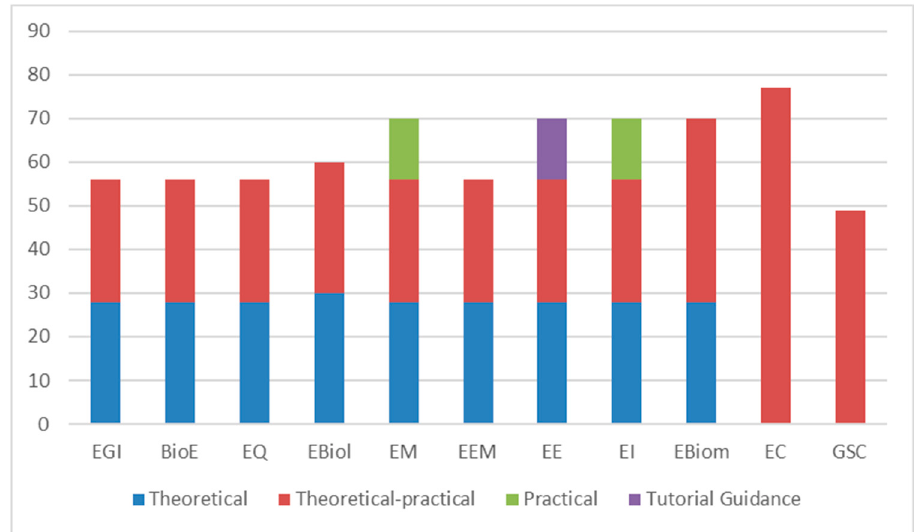
Figure 2. On-site classes distribution of the different CUs at ISEC.